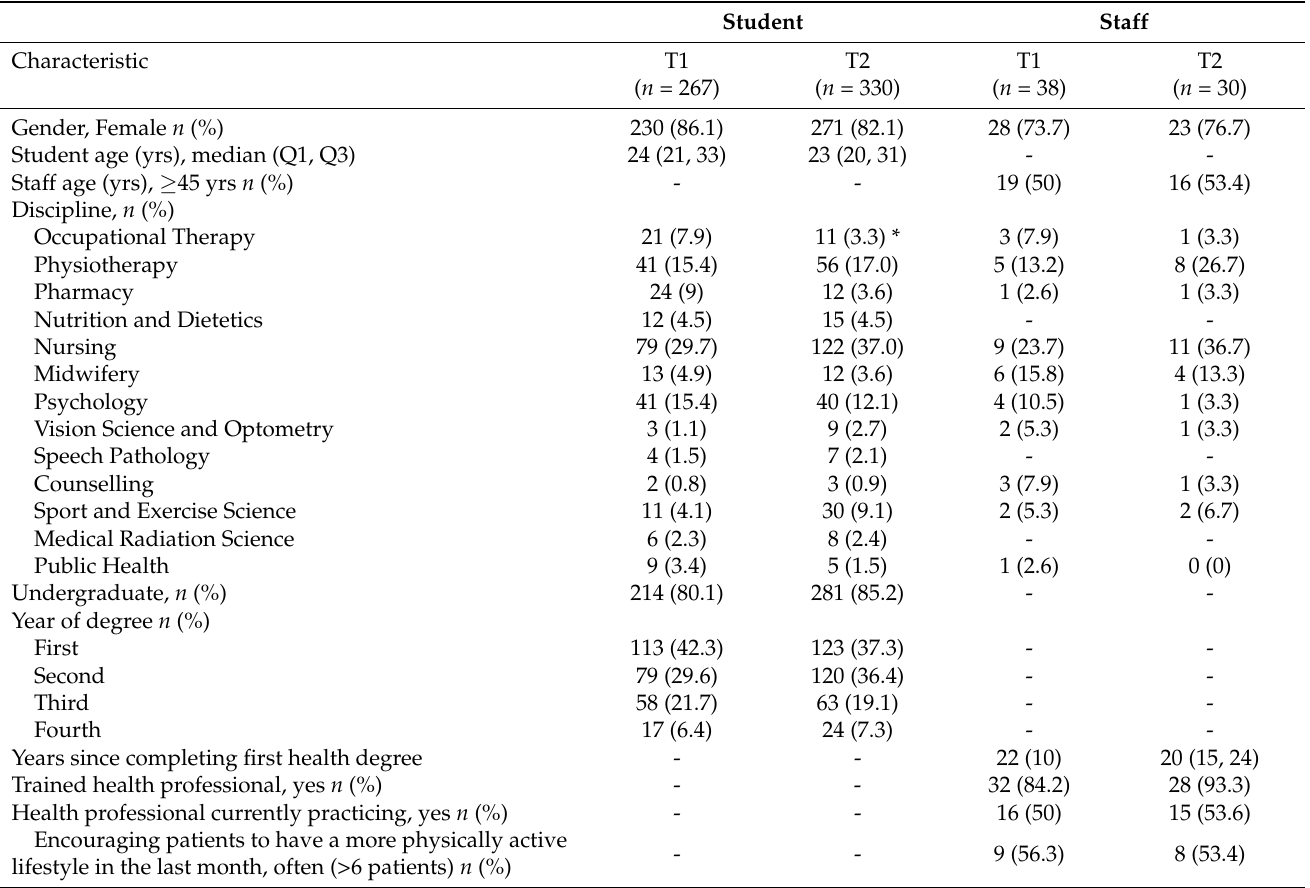
Table 1. Student and staff participant characteristics pre- and